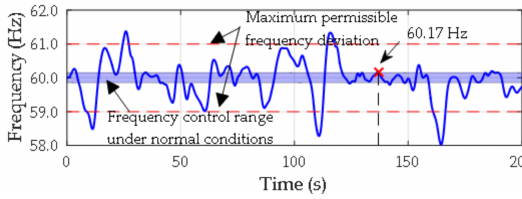
Figure 11. Time domain behavior of grid frequency.